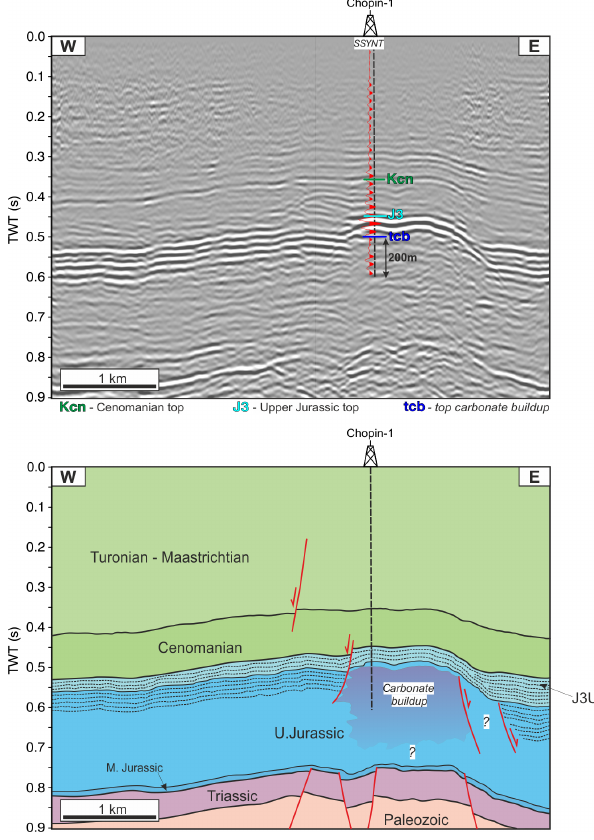
Figure 11. Uninterpreted and interpreted seismic profile across the carbonate buildup complex (see Fig. 5 for location). This carbon- ate buildup was partly drilled by the Chopin-1 well. Well tops, the interpreted top of the carbonate buildup (tcb) and the synthetic seis- mogram (SSYNT) are shown (see Fig. 6 for details).